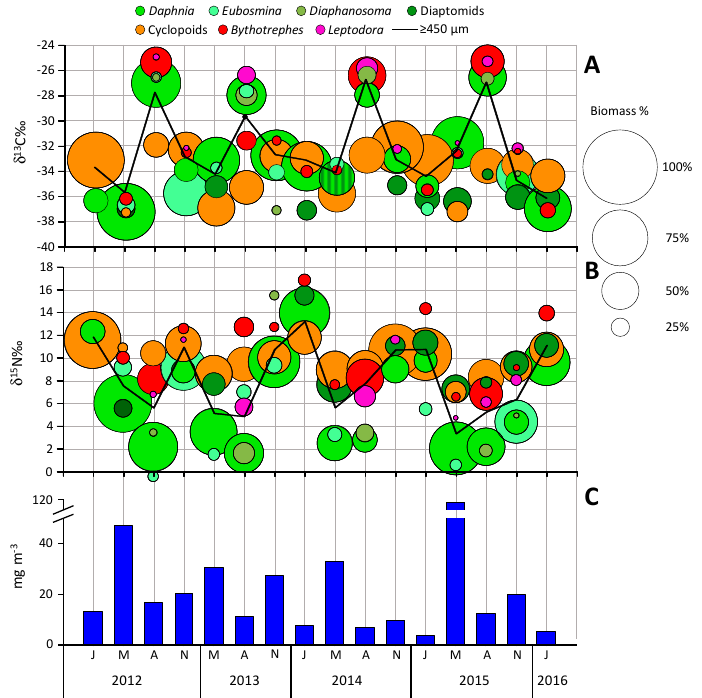
Figure 2. ( A ) Biomass percentage composition of planktonic crustacean taxa (bubbles) of Lake Maggiore and their δ 13 C‰ values (bubble centers) and δ 13 C‰ values of pooled samples (black line); ( B ) biomass percentage composition of planktonic crustacean taxa (bubbles) of Lake Maggiore and their δ 15 N‰ values (bubble centers) and δ 15 N‰ values of pooled samples (black line); ( C ) total biomass of Lake Maggiore planktonic crustacean taxa. All data refer to the fraction ≥ 450 µm.